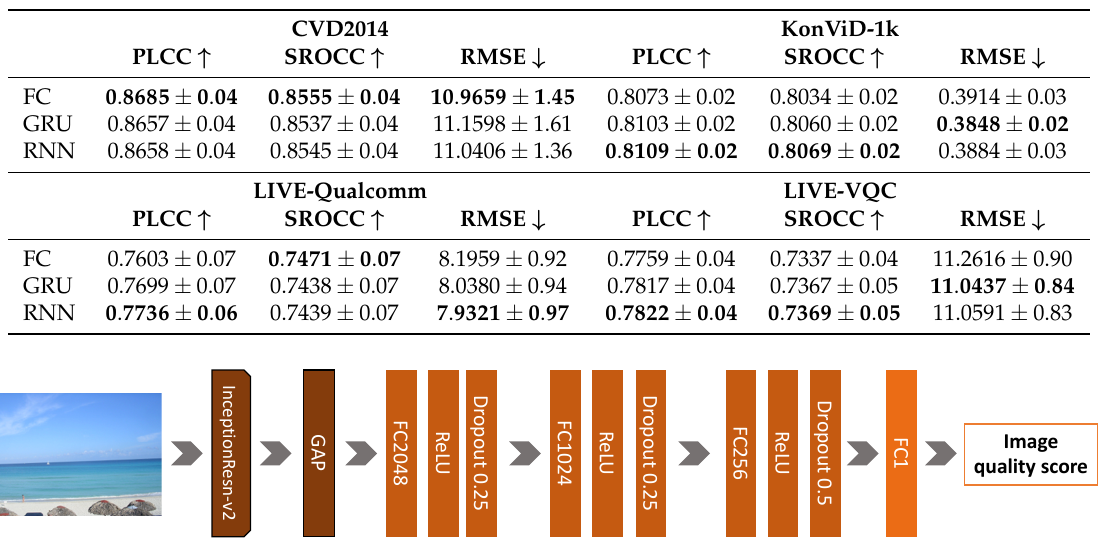
Table 5. Mean PLCC, SROCC, and RMSE across 100 train-val-test combinations on the four considered databases by using different methods for temporal modeling, namely FC, GRU, or RNN.